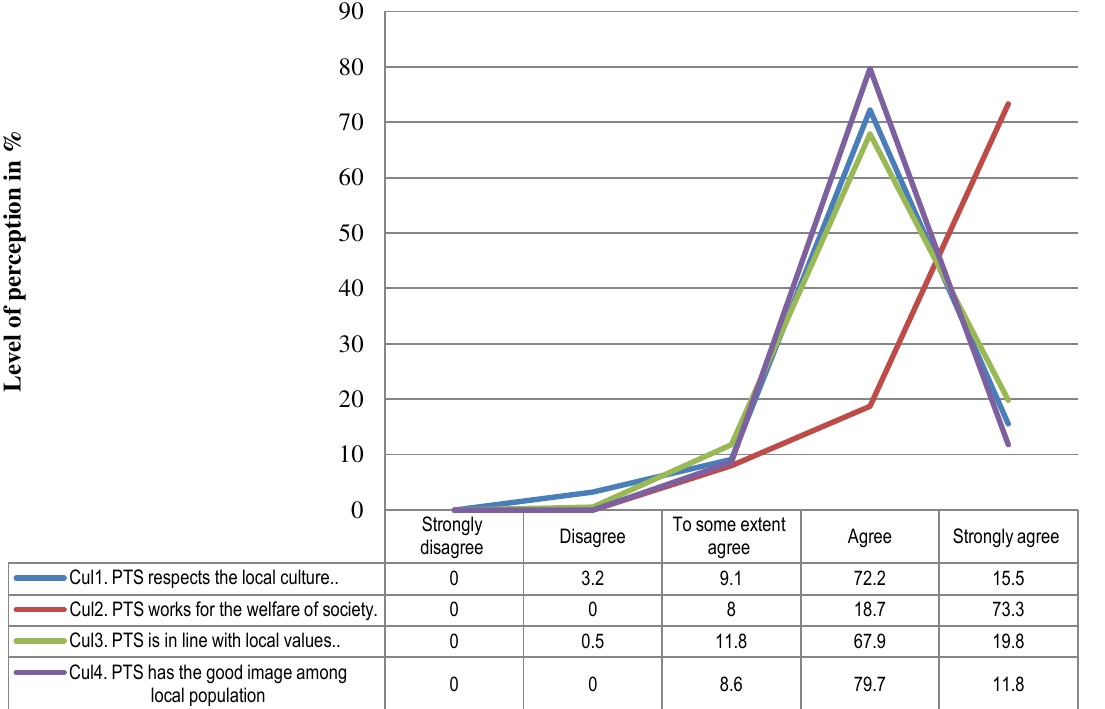
Fig. 11. Level of perception on compassion about PTS percentage of research respondents